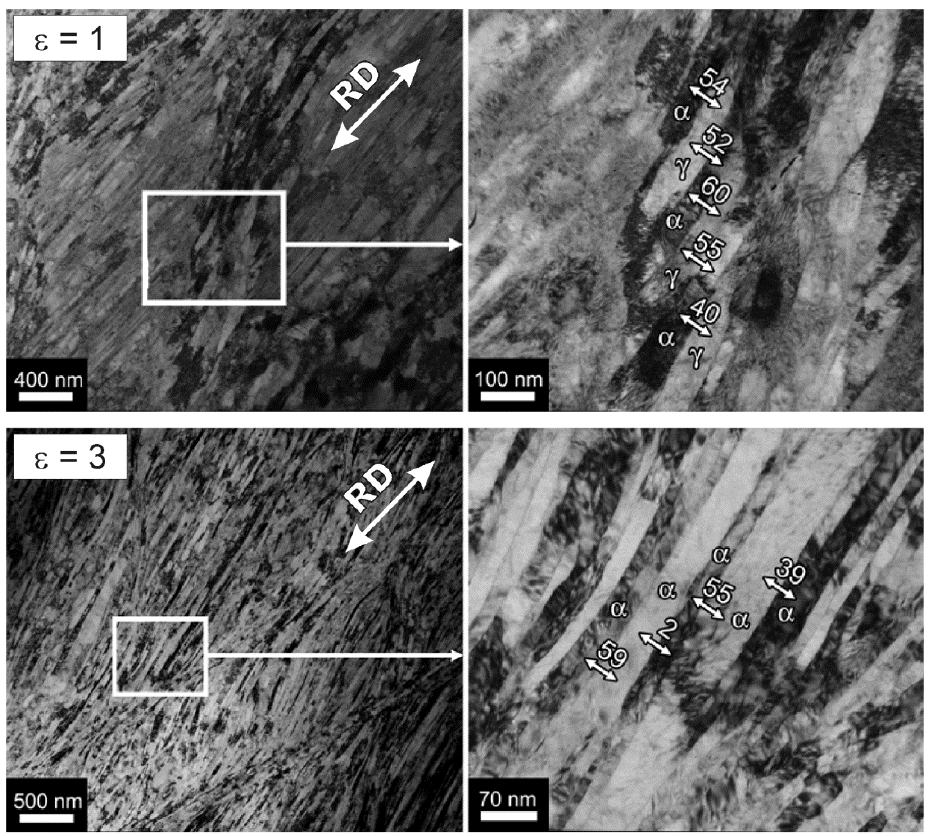
Figure 3. Fine structures evolved in a 304L stainless steel subjected to cold rolling to total strains of ε =1 and ε = 3. The RD indicates the rolling direction. The numbers indicate the boundary misorientations in degrees.